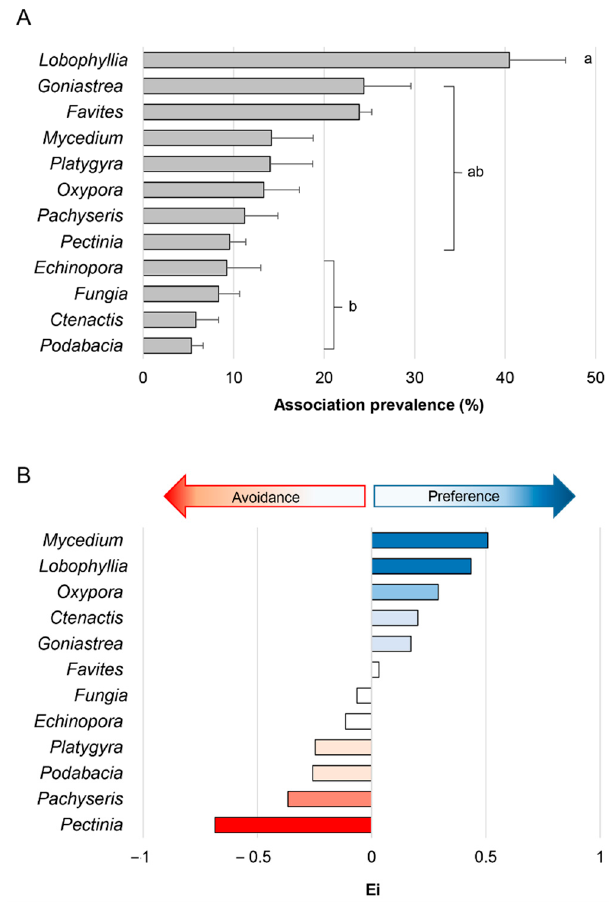
Figure 4. ( A ) Prevalence (%) of Waminoa sp.–corals associations by genus in the whole study area. Data are expressed as mean ± SEM. Letters denote Tukey’s significant differences among the different groups ( p < 0.05); the same letter indicates no significant difference ( p ≥ 0.05). ( B ) Host preferences of Waminoa sp. according to the Van der Ploeg and Scavia selectivity coefficient Ei ( − 1 = complete avoidance; 0 = random choice; +1 = exclusive preference) for each coral genus. In both graphs, only the coral genera with an association prevalence > 5% are reported.